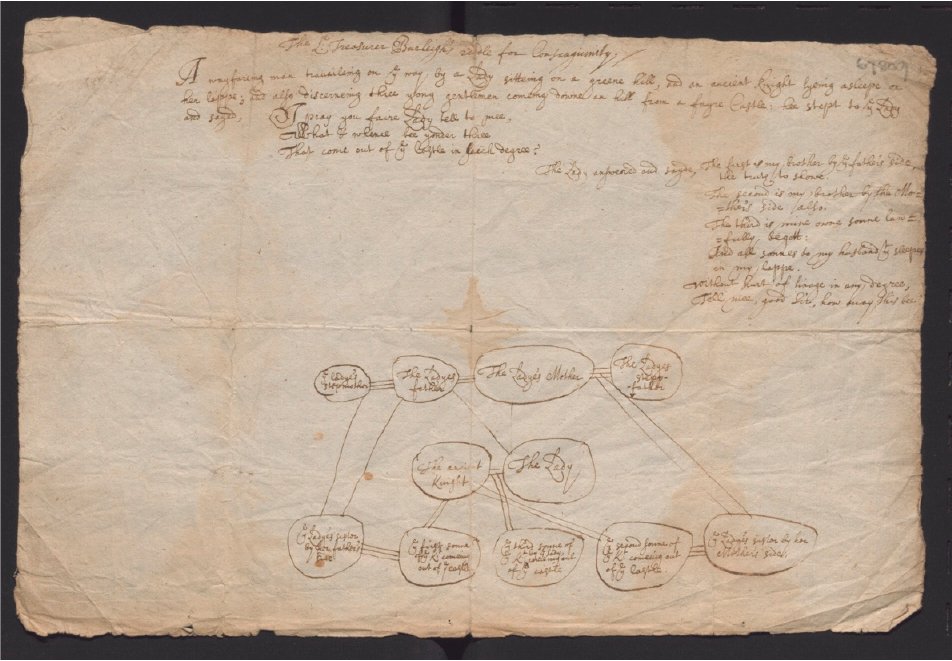
Figure 12. ‘The L[or]d Treasurer Burleigh’s riddle for Consanguinity’, manuscript on paper,